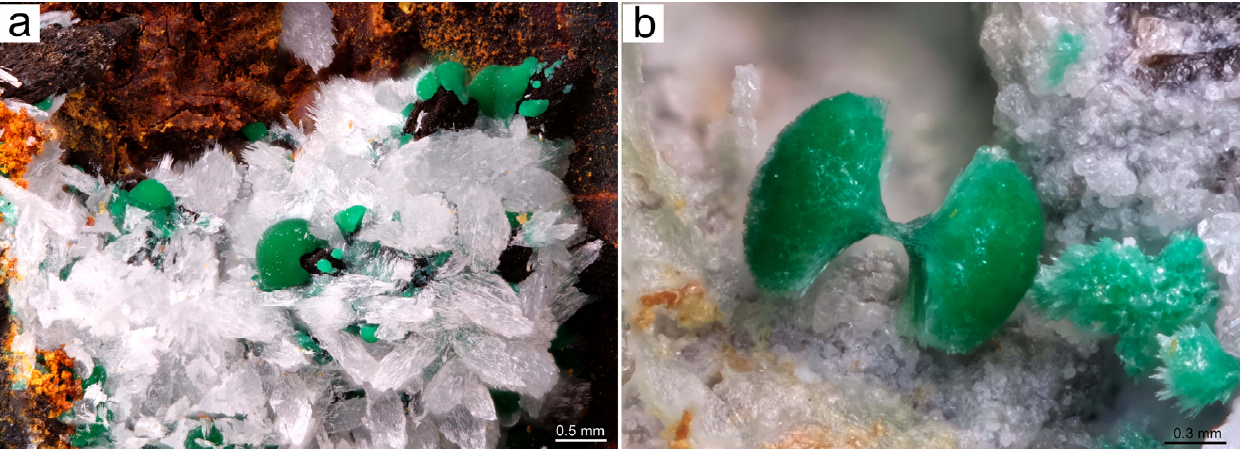
Figure 13. Raman spectrum of langite crystals from the Mastricarro Barite Mine (Catanzaro, southern Italy). In the insert is the structure of the langite [40,46].